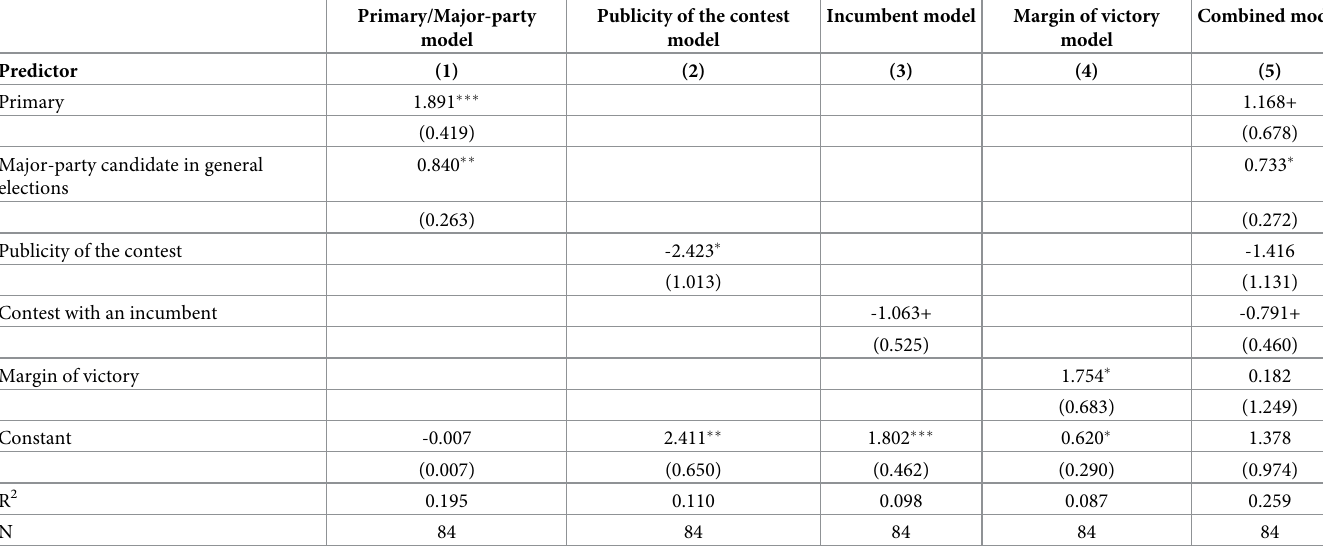
Table 1. Moderators of the primacy effects of 2000–2004 primary candidates and 2012–2016 general election candidates in New